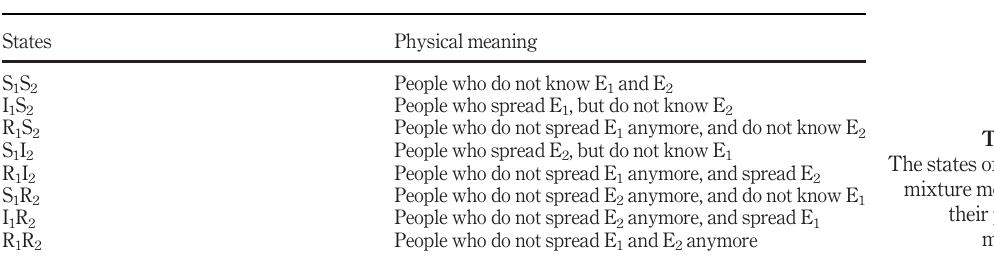
Table II. The states of the